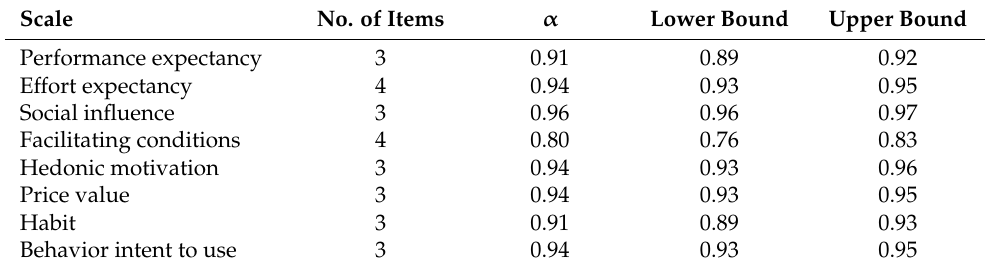
Table 7. Reliability